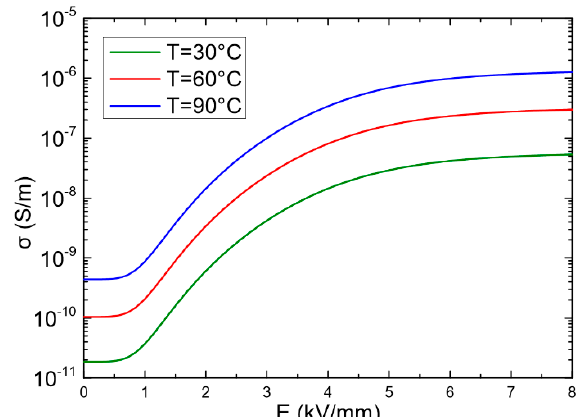
Figure 4. Conductivity of novel nonlinear resistive field grading material (FGM) with temperature and electric field with a moderate nonlinear coefficient γ = 6.